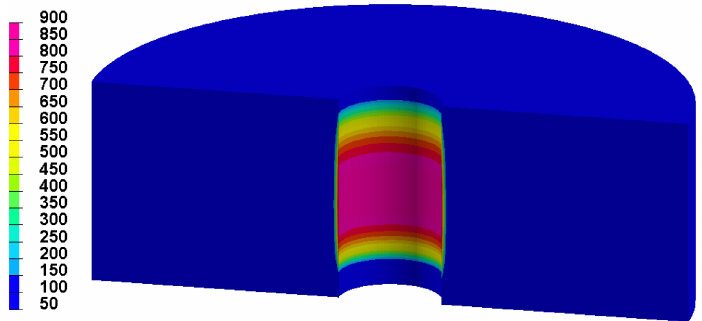
Figure 18. Distribution of hoop residual stresses